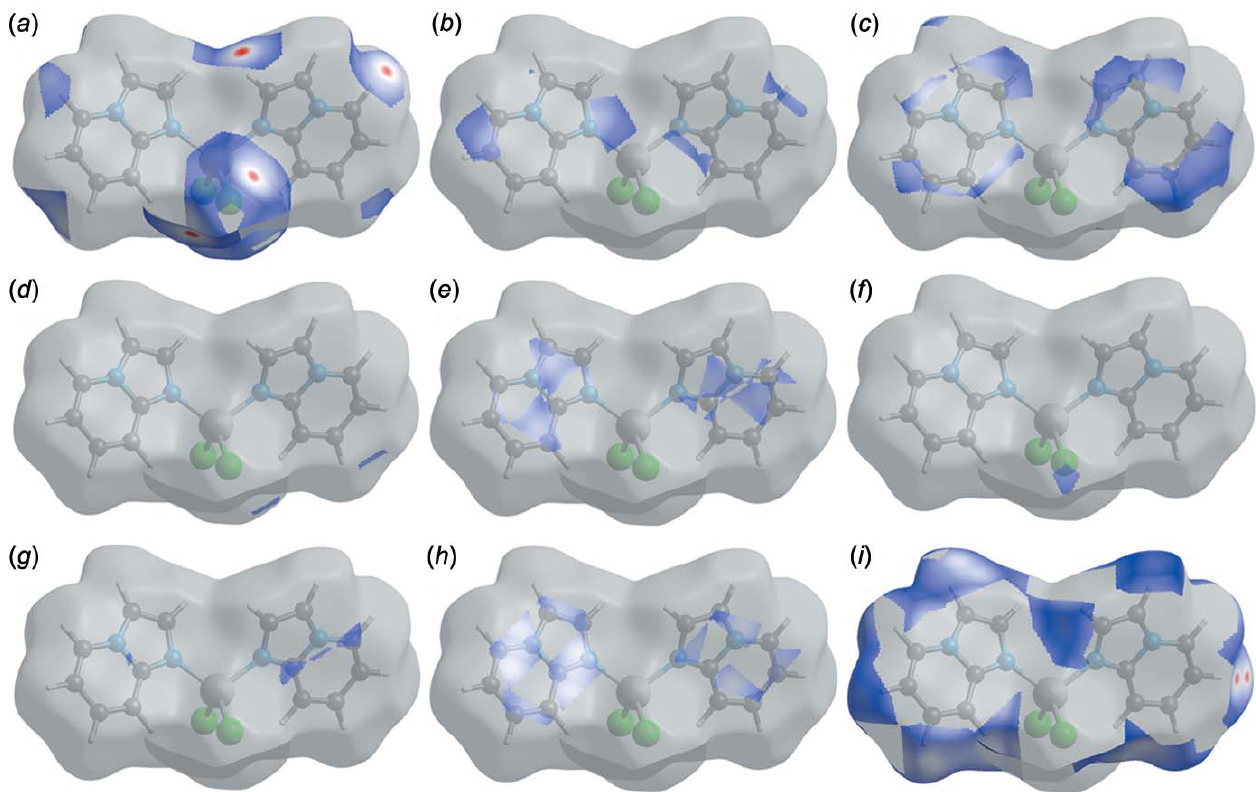
Figure 6 Perspective view of the decomposed d norm surfaces of the title structure corresponding to ( a ) Cl (cid:2)(cid:2)(cid:2) H/H (cid:2)(cid:2)(cid:2) Cl; ( b ) N (cid:2)(cid:2)(cid:2) H/H (cid:2)(cid:2)(cid:2) N; ( c ) C (cid:2)(cid:2)(cid:2) H/H (cid:2)(cid:2)(cid:2) C; ( d ) Cl (cid:2)(cid:2)(cid:2) C/C (cid:2)(cid:2)(cid:2) Cl; ( e ) N (cid:2)(cid:2)(cid:2) C/C (cid:2)(cid:2)(cid:2) N; ( f ) Cl (cid:2)(cid:2)(cid:2) Cl; ( g ) N (cid:2)(cid:2)(cid:2) N; ( h ) C (cid:2)(cid:2)(cid:2) C and ( i ) H (cid:2)(cid:2)(cid:2) H contacts.